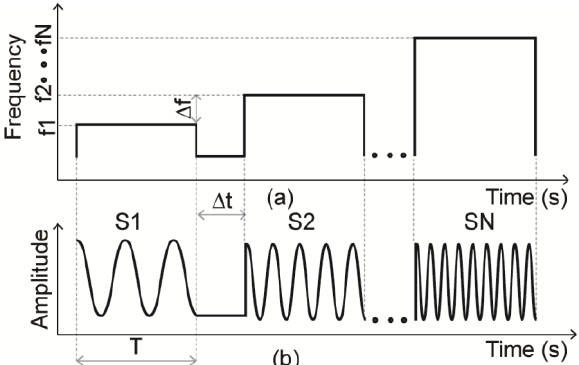
Figure 14. Stepped-frequency continuous-wave radar (SFCW) signal: ( a ) frequency variation over time, ( b ) instantaneous chirp signals.